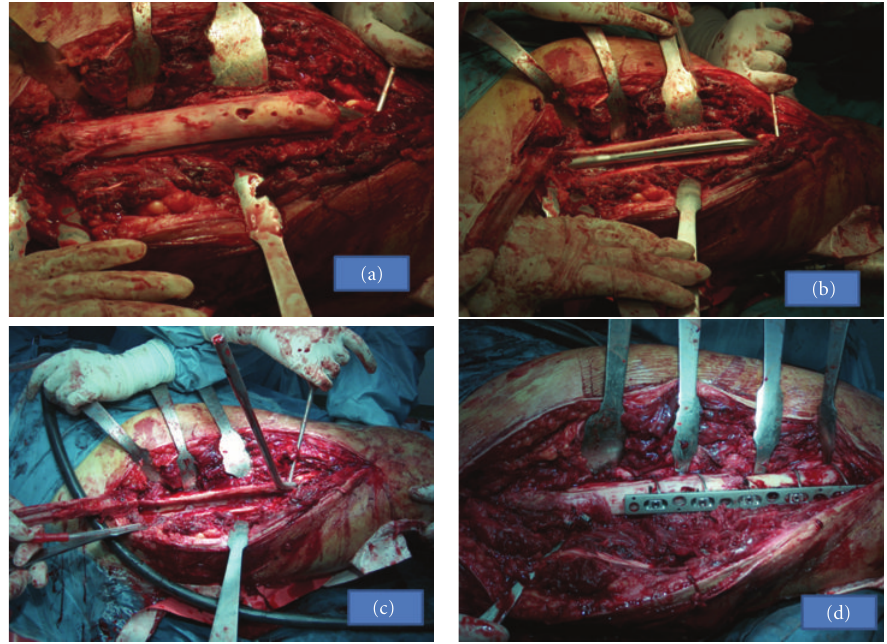
Figure 4: Surgical technique. (a) A proper osteotomy was performed as to facilitate the creation of a longitudinal bone window along the anterolateral side of the distal part of the femoral shaft. The osteotomy extended from the fracture site distally to the greater trochanter. (b) Anterolateral window of the femoral shaft approximately 2 cm in width. (c) Removal of the intramedullar nail through the window. (d) Reattachment of the bone window, after the placement of a new reconstruction nail, which was secured by a buttress plate (Accord) and cerclage wires.